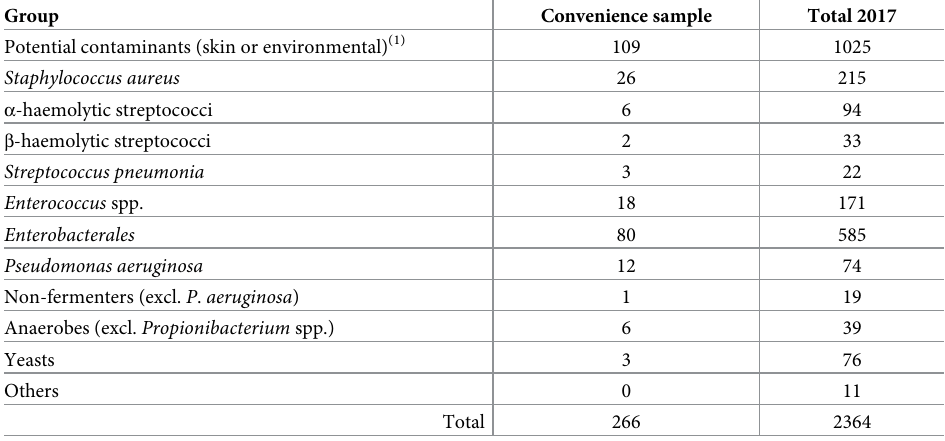
Table 2. Frequency distribution of bacteria and yeasts in the convenience sample and in all positive blood cultures for the reference year 2017.